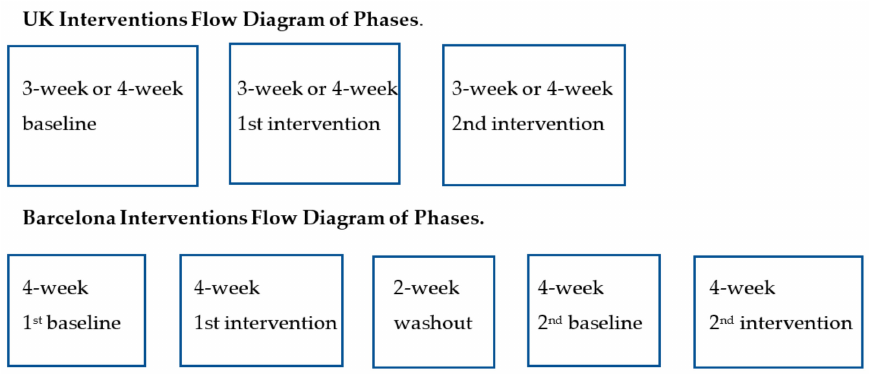
Figure 1. Flow diagrams of the intervention phases in the UK and